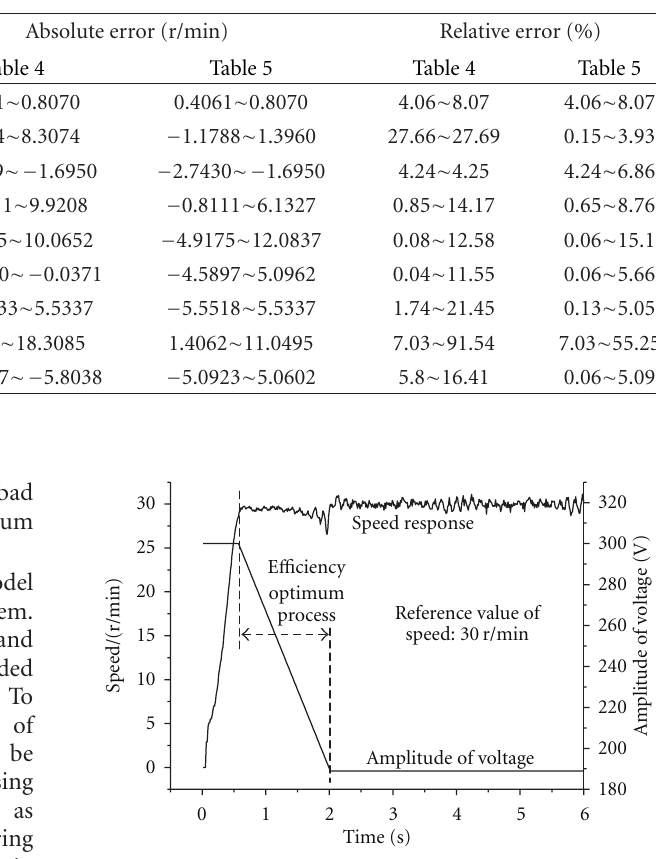
Figure 5: Speed response with e ffi ciency